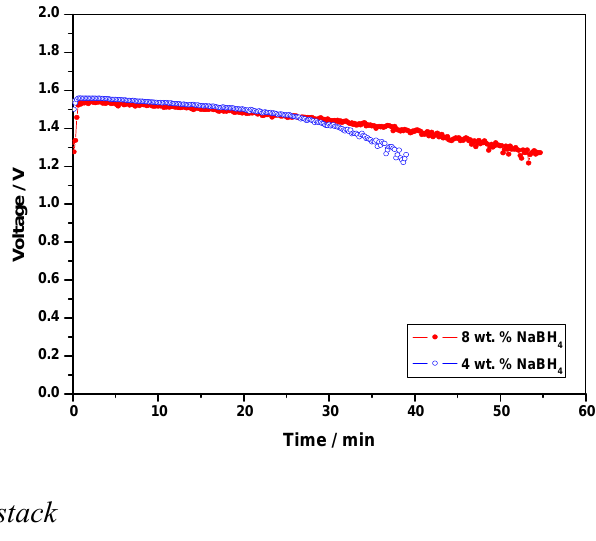
Figure 5. Performance data for the DBFC with 4 wt. % and 8 wt. % anolyte and 8 M H as the catholyte at a load current-density of 65 mA cm -2